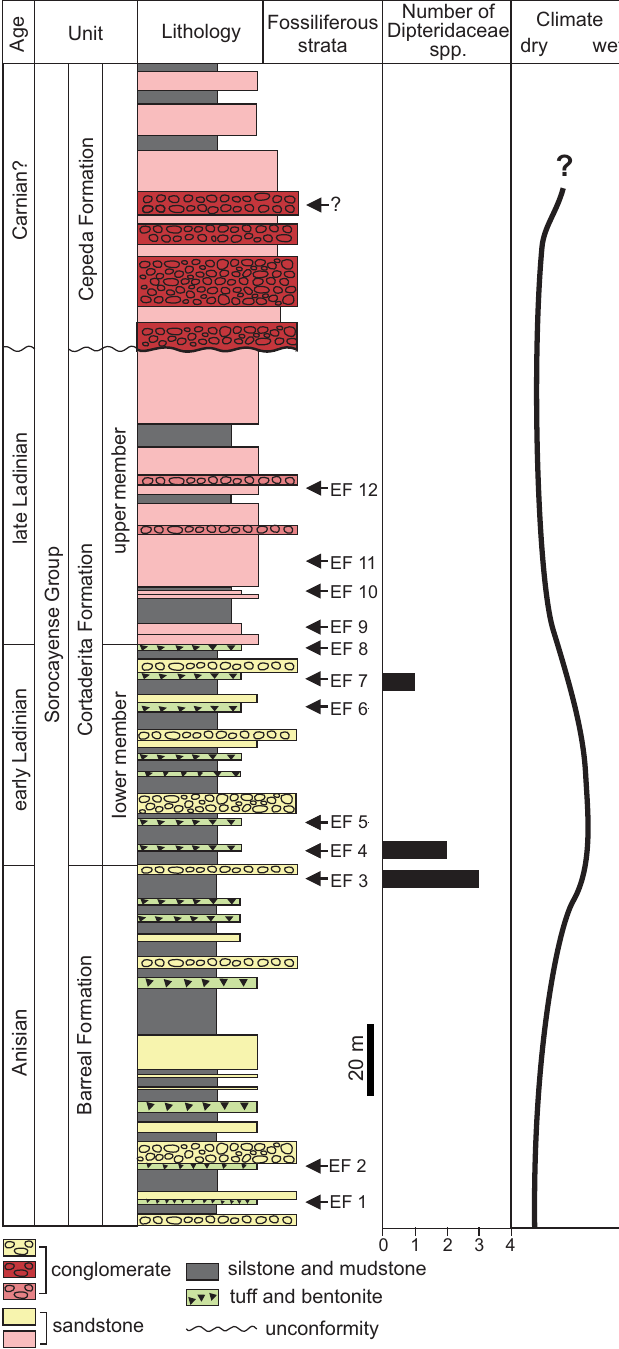
rassic of Great Britain.